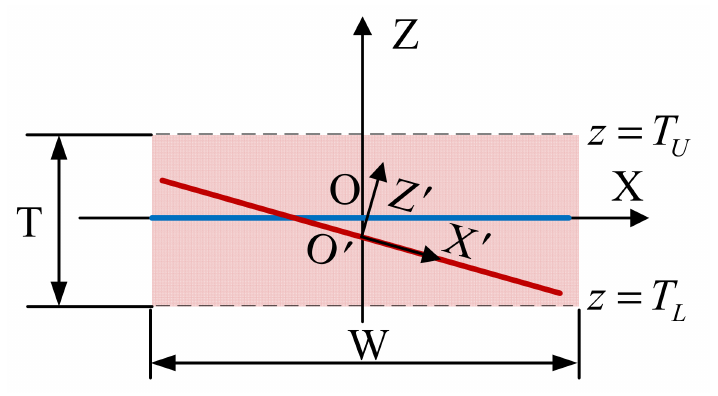
Figure 2. Range of variation of plane features in the x-z